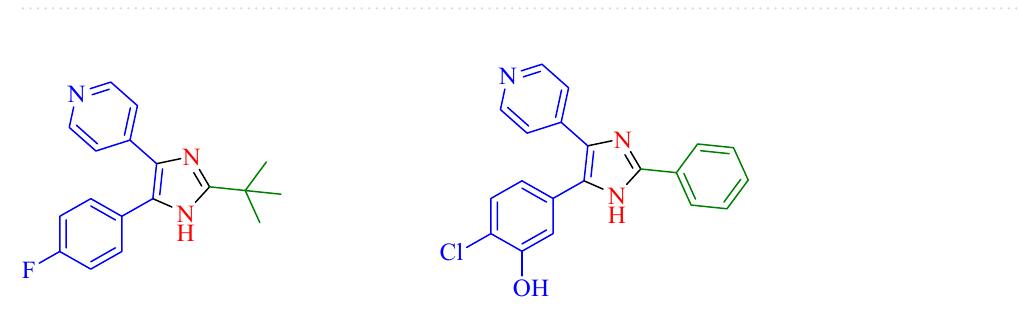
Figure 1. Schematic representation of the biosynthetic pathway of Cr 2 O 3 nanoparticles using Zingiber officinale extract.